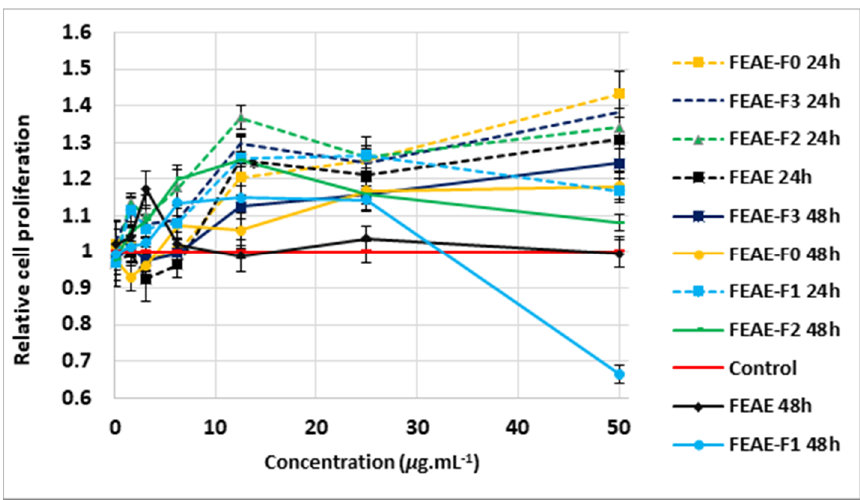
Figure 6. Cell proliferating effect of B. pilosa ethyl acetate extract (BEAE) and resulting fractions BEAE-F3 and BEAE-F4 after 24 h and 48 h of treatment of dermal papilla cells with concentrations 0.1 to 50 µg.mL −1 normalized and compared the control. Error bars represent SEM. Molecules 2020 , 25